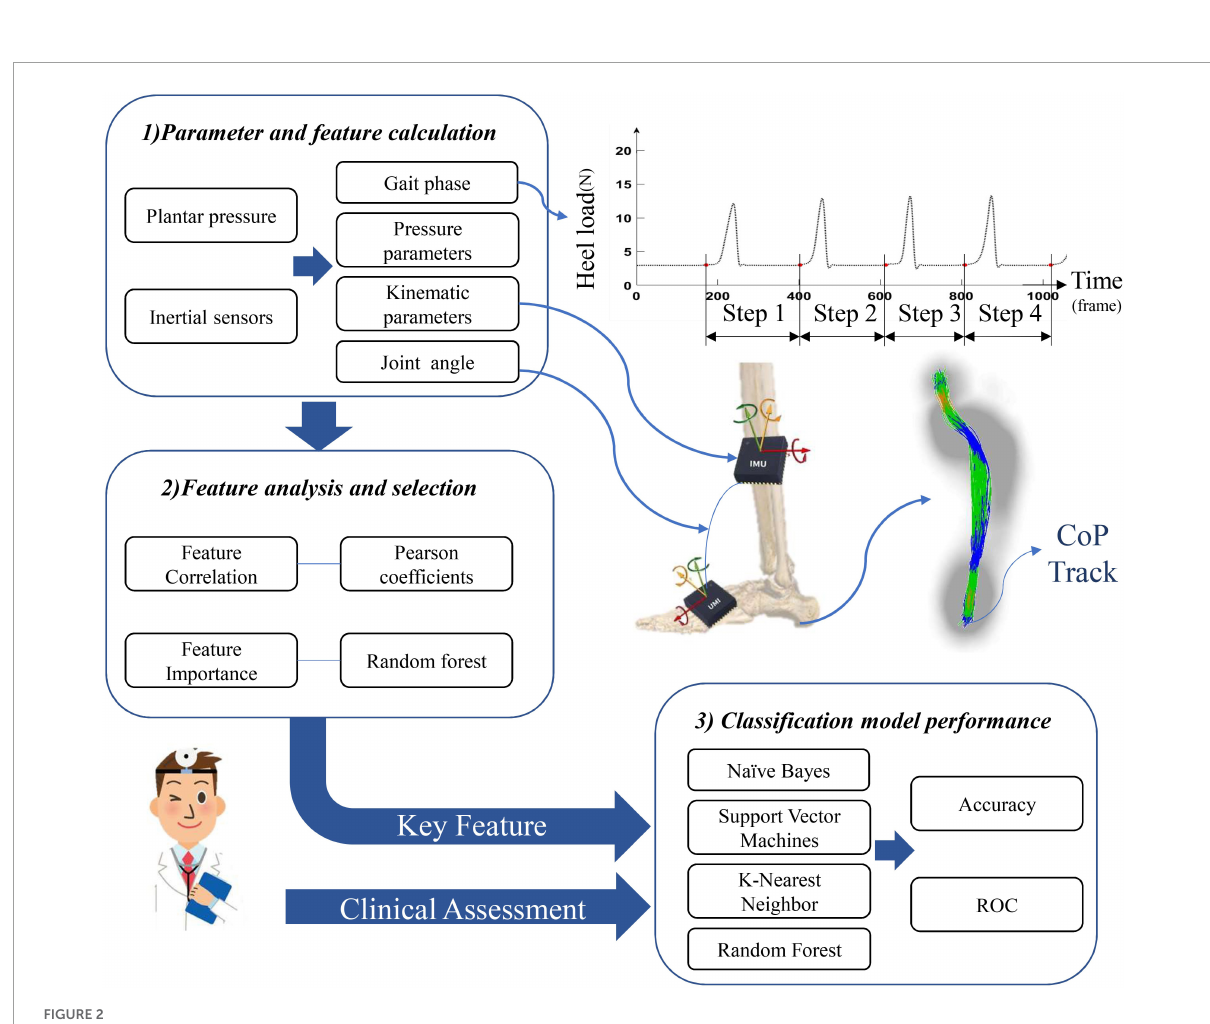
FIGURE2 Flowchart of the data